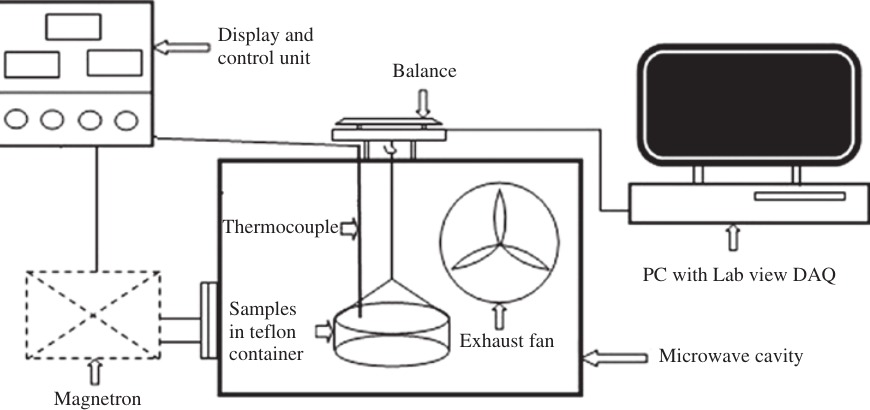
Figure 1: Schematic diagram of the microwave drying